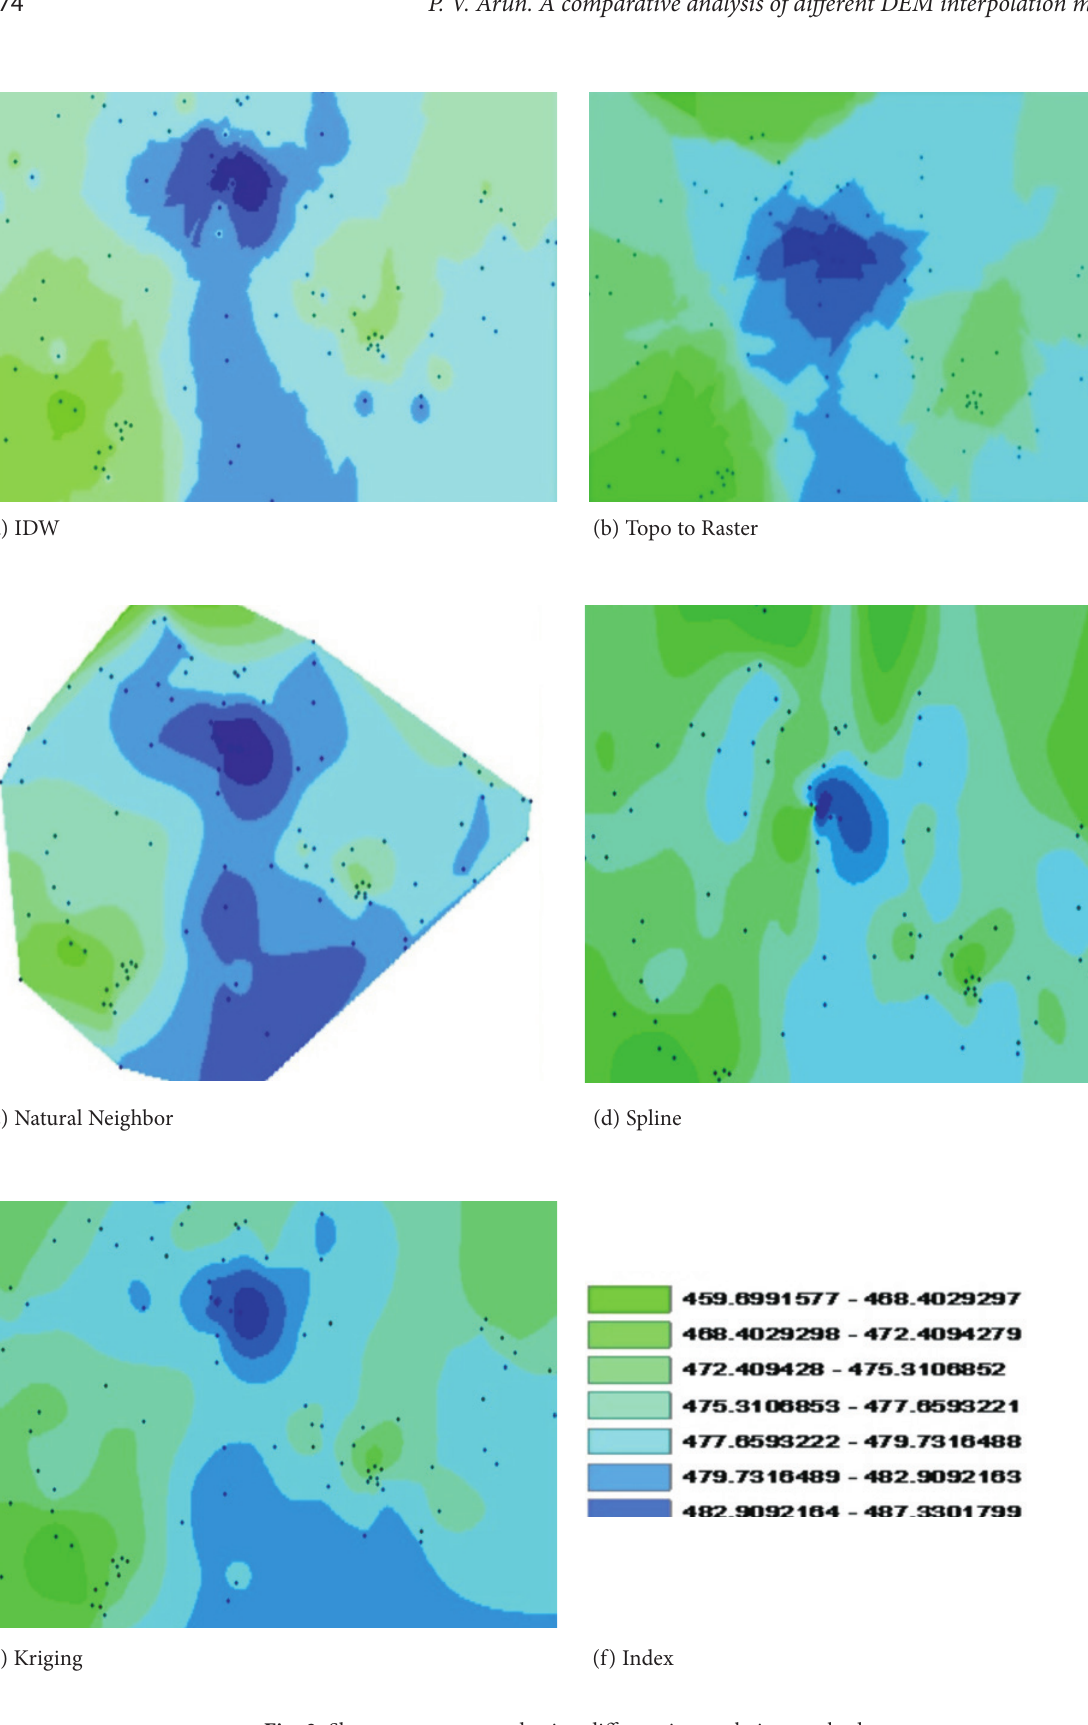
Fig. 2. Slope maps generated using different